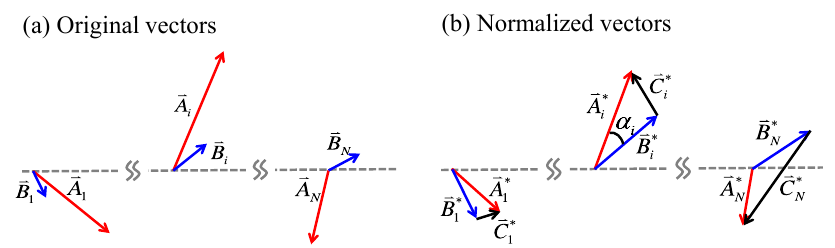
Figure 1. Schematic illustration of two vector sequences. Panel (a) original vectors and (b) normalized vectors. The length of vector se- quence A i is systematically greater than that of vector sequence B i . The normalization only alters the lengths of vectors without changes in